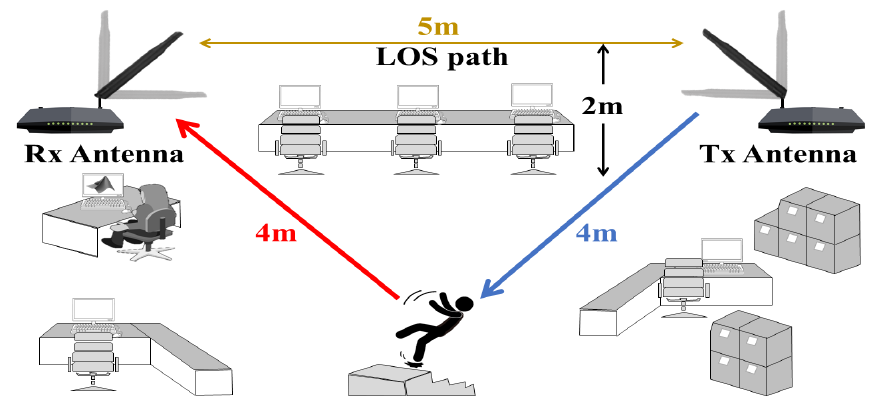
Figure 5. Schematic of the test scenario.